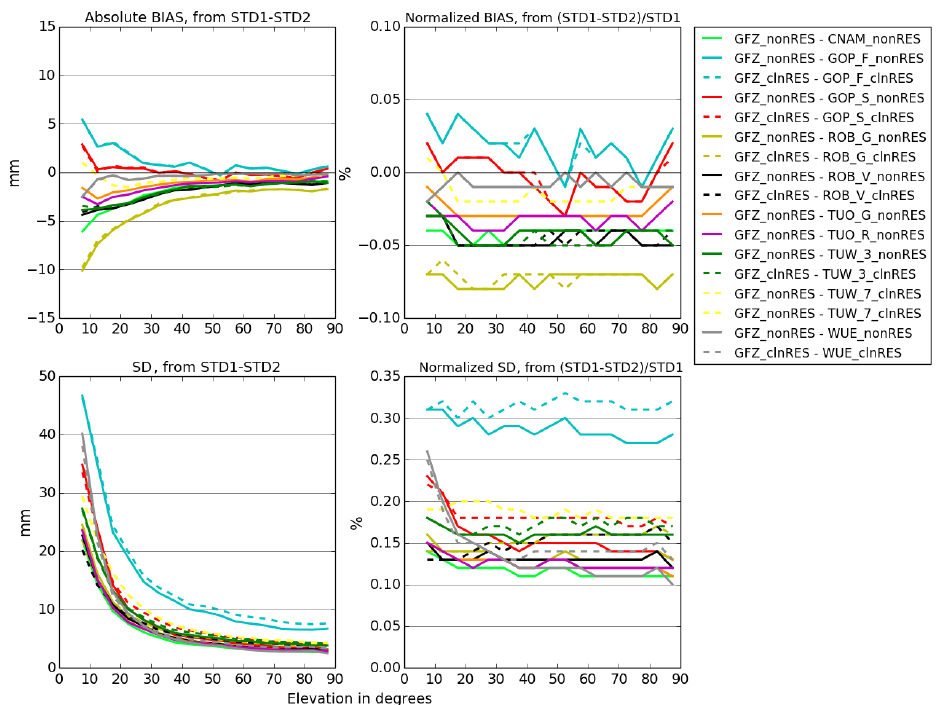
Figure 7. Comparison of individual GNSS STD solutions against GFZ STD solution at station POTS, in slant